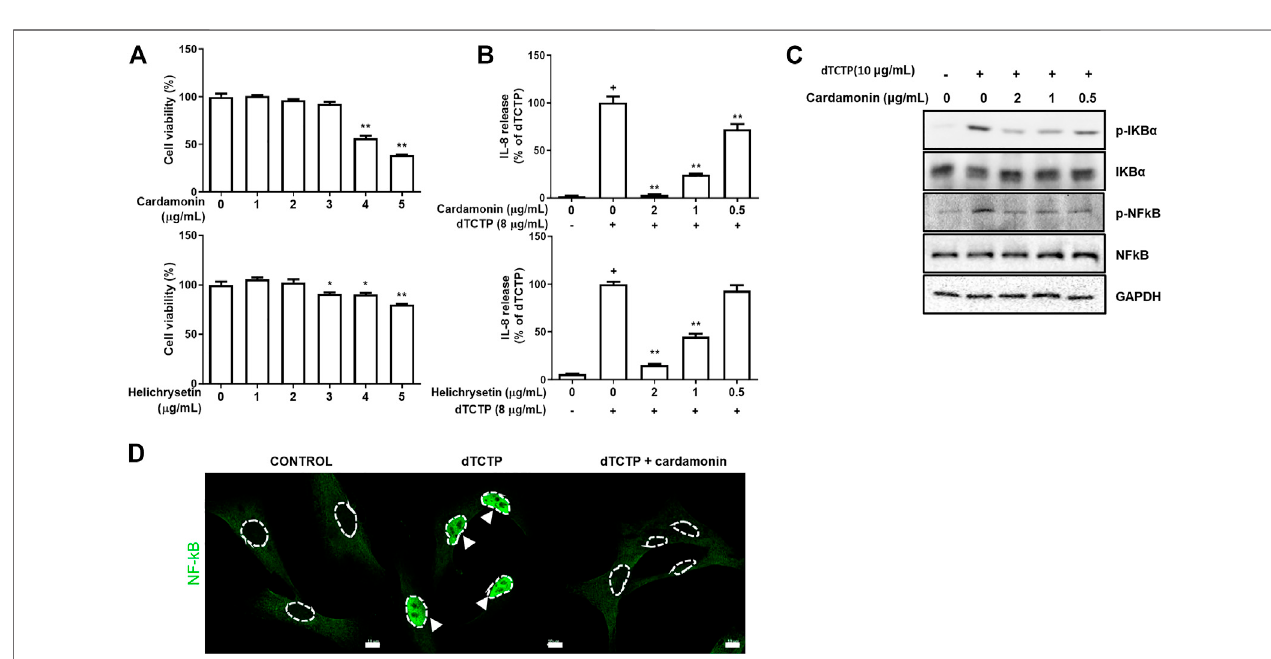
FIGURE 2 | Anti-in fl ammatory effects of cardamonin and helichrysetin in vitro studies. Cytotoxicity of cardamonin and helichrysetin (A) in BEAS-2B cells. Cells were seeded into 96 well plates and treated with various concentrations of cardamonin for 24 h. Cell viability was assessed using a CCK-8 assay. The ability of cardamonin and helichrysetin (B) to inhibit IL-8 secretion stimulated by dTCTP in BEAS-2B cells. The effect of cardamonin on NF- κ B activation during the dTCTP induced IL-8 secretion in BEAS-2B cells. Western blotting detection of family of p-IKB α , IKB α , p-NF κ B, and NF κ B in BEAS-2B cells. BEAS-2B cells were treated with vehicle as a negative control, dTCTP alone, or dTCTP plus cardamonin (0.5, 1, or 2 μ g/ml) for 90 min (C) . dTCTP induced nuclear translocation of NF κ B was inhibited with cardamonin (2 μ g/ml) in confocal microscopy (D) . These values are expressed as the mean ± SEM. n (cid:1) 3, + p < 0.05 compared with the negative control; * p < 0.05, ** p < 0.01 compared with compared with the group treated with the dTCTP